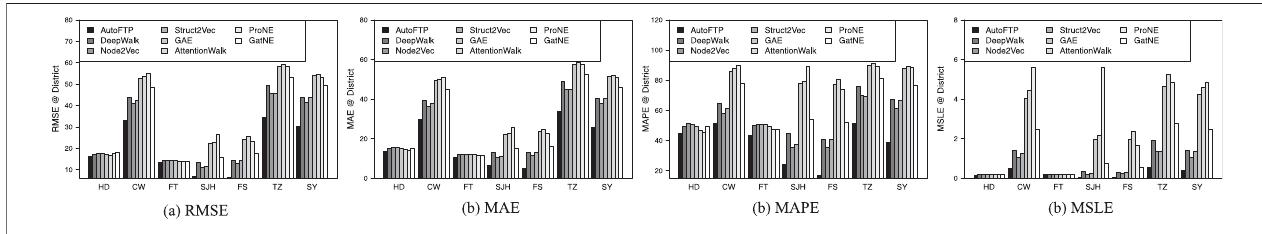
FIGURE 11 | Robustness check according to geographical district.